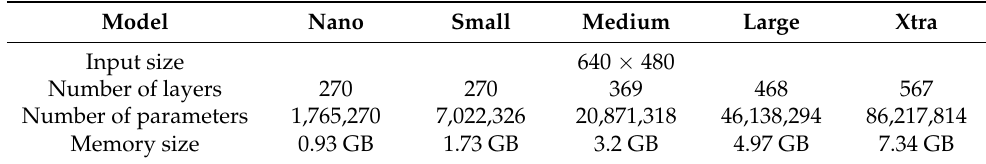
Table 1. Described models in numbers of